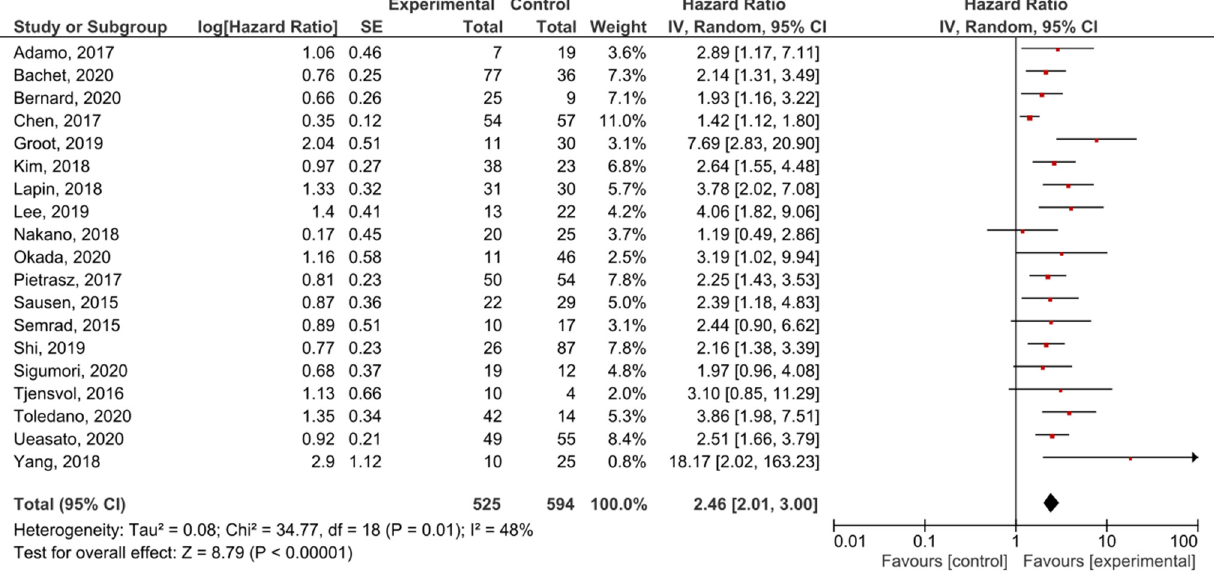
Figure 4. Forest plot presenting the relationship between the presence of KRAS mutations before treatment in PDAC patients and PFS.